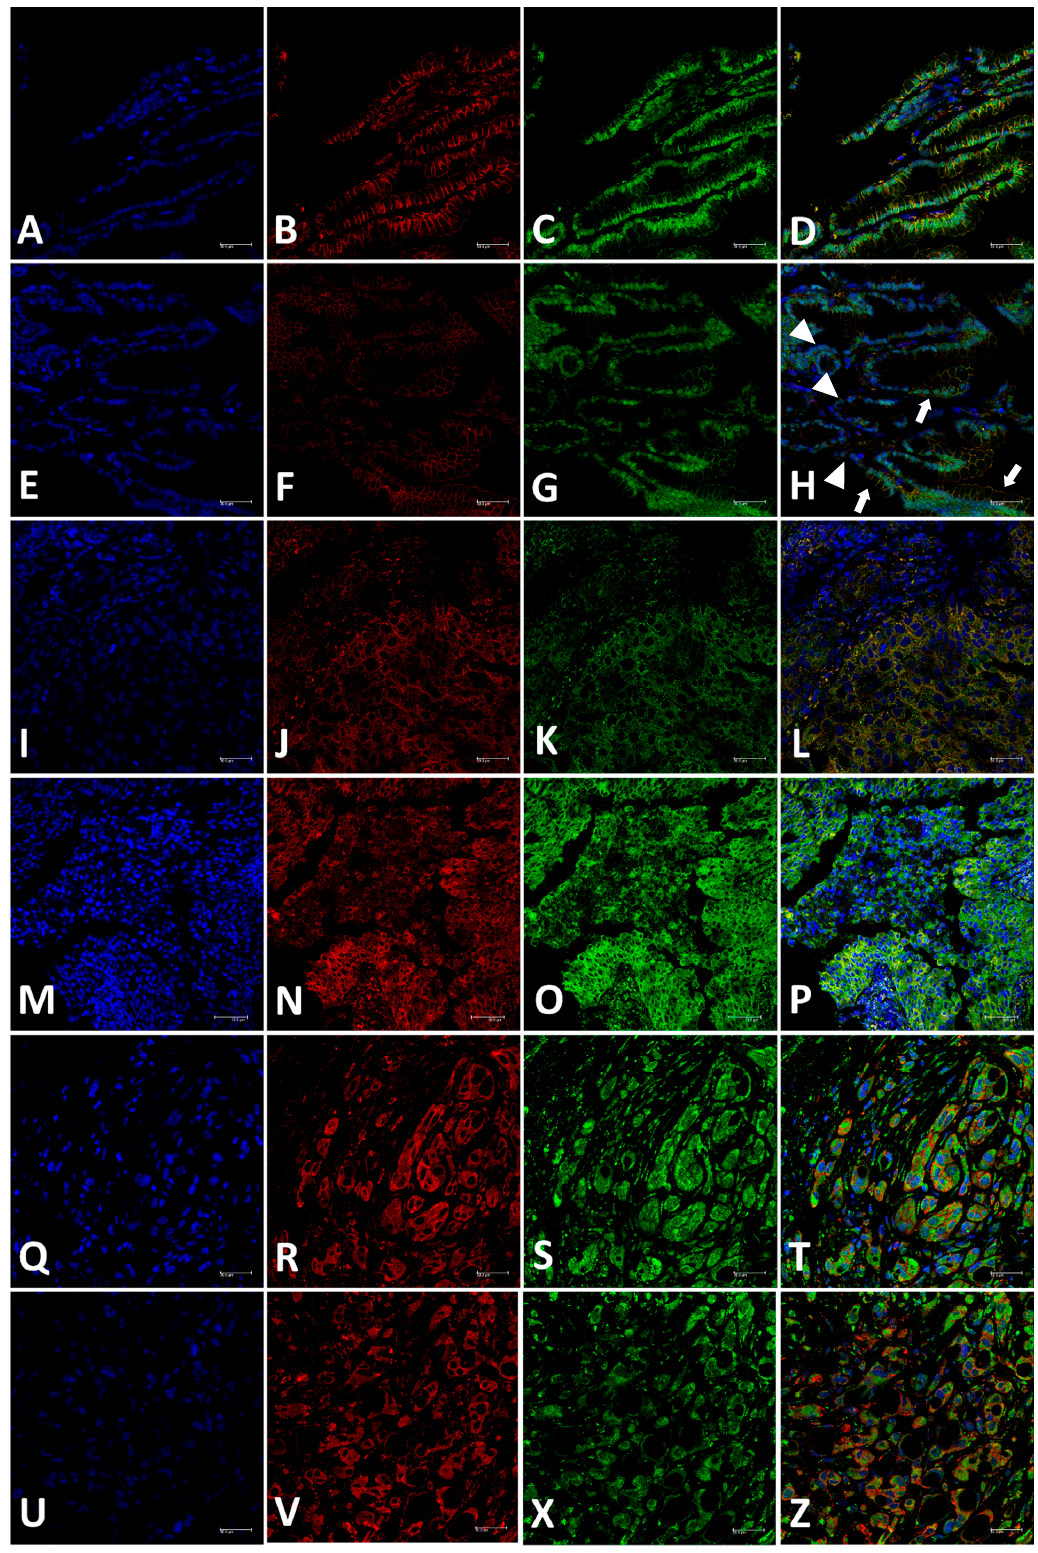
Figure 2. Immunofluorescence analysis of androgen receptor (AR) (green color) and P-glycoprotein (P-gp) (red color) in canine prostatic samples. ( A – D ): expression of P-gp ( B ) and AR ( C ) in normal prostate samples and merged image ( D ) demonstrating the doubled stained cells with AR